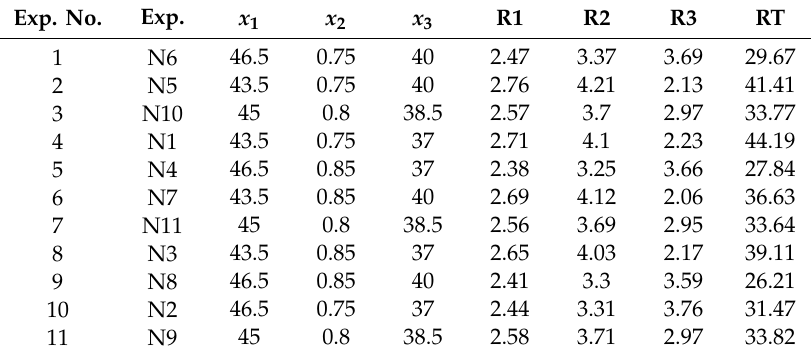
Table 4. Full factorial screening design and the results of observed responses (CMAs). Exp. No.